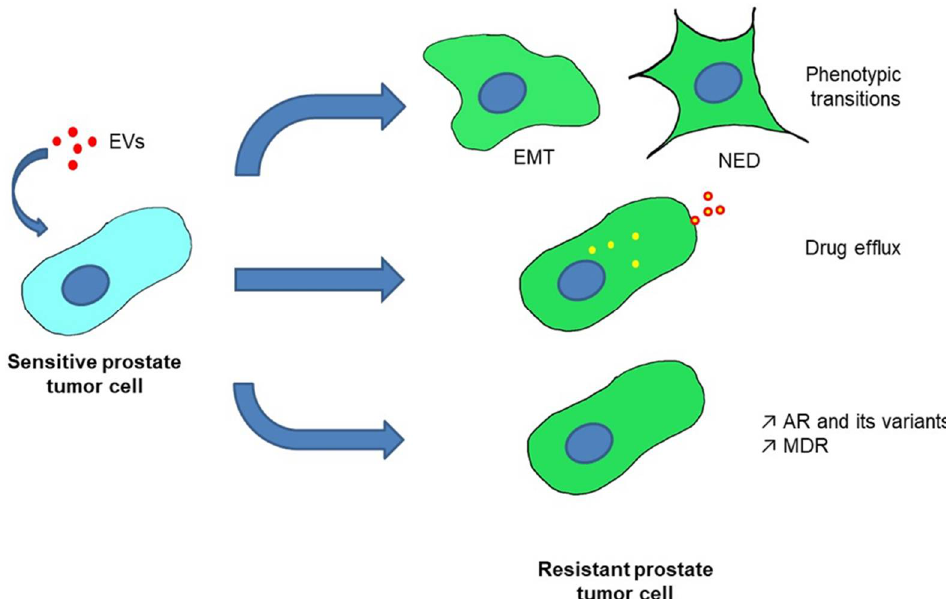
Figure 2. The main mechanisms of therapeutic resistance induced by EVs in prostate tumor cells. Roles of EVs have been demonstrated in the induction of tumor plasticity, elimination of drug inducing drug efflux or augmentation of gene expression or protein/mRNA transfer via EVs. EMT = Epithelial to Mesenchymal Transition, NED = Neuroendocine Differentiation, AR = Androgen Receptor and MDR = Multi Drug Resistance.